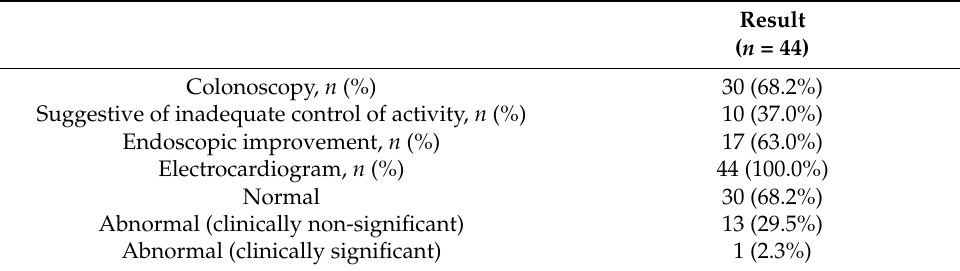
Table 4. Colonoscopy and electrocardiogram